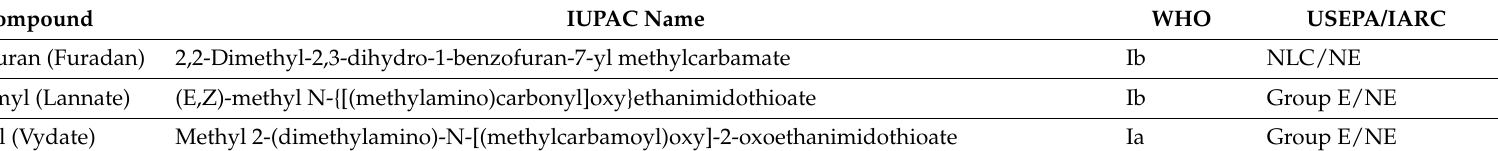
Table 2. List of the more frequent pesticides used by the exposed group and their hazard